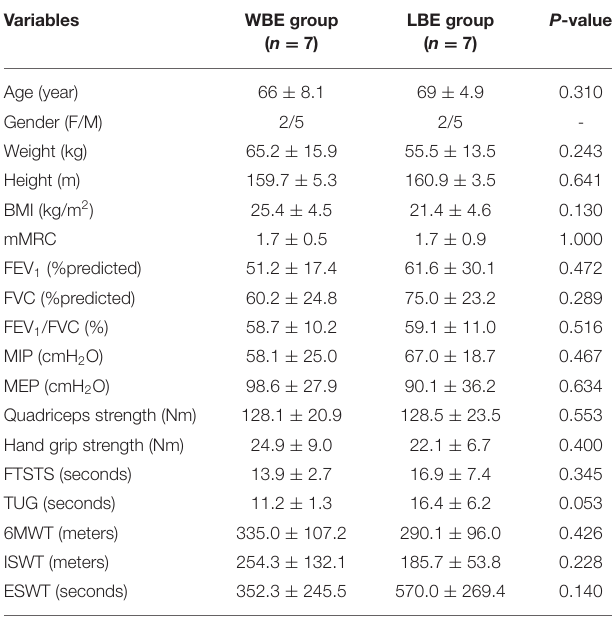
TABLE 3 | Baseline